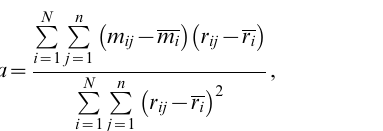
p(cid:7) (cid:8) 2 p { ffiffiffiffiffiffiffiffiffiffiffi ffiffiffiffiffiffiffiffiffiffiffi p 2 ( x ) p 1 ( x ) , ð 6